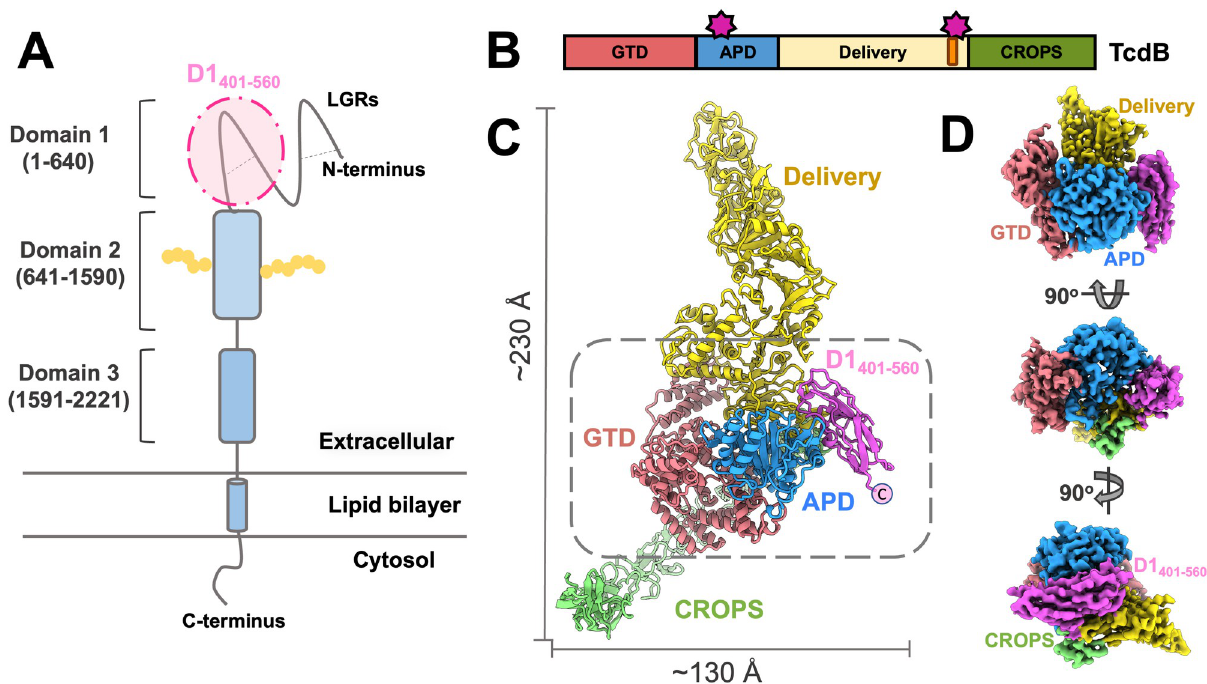
Fig 1. The overall structure of the complex between TcdB and D1 401-560 . (A) The scheme for the domain organization of CSPG4. The 3 domains of CSPG4 are shown in a cartoon style, with their corresponding residues labeled. Yellow connected dots represent glycosylation on Domain 2. D1 401-560 is highlighted by a pink oval. (B) The color scheme of TcdB domains. Regions, which bind D1 401-560 , are labeled by magenta stars. The D97 region is labeled orange. (C) The model of the full-length TcdB-D1 401-560 complex, with domains labeled and colored based on the scheme in Panel B. The dashed gray box indicates the central region for the focused cryo-EM map refinement. The dimensions of the complex are labeled. (D) The density map of the central region, viewed from different angles, with each domain color coded. APD AU : AbbreviationlistshavebeencompiledforthoseusedinFigs 1 (cid:0) 4 : Pleaseverifythatallentriesarecorrect : , autoprocessing domain; CROPS, combined repetitive oligopeptides; CSPG4, chondroitin sulfate proteoglycan 4; GTD, glucosyltransferase domain; LGR, laminin G-type region; TcdB, Toxin B.